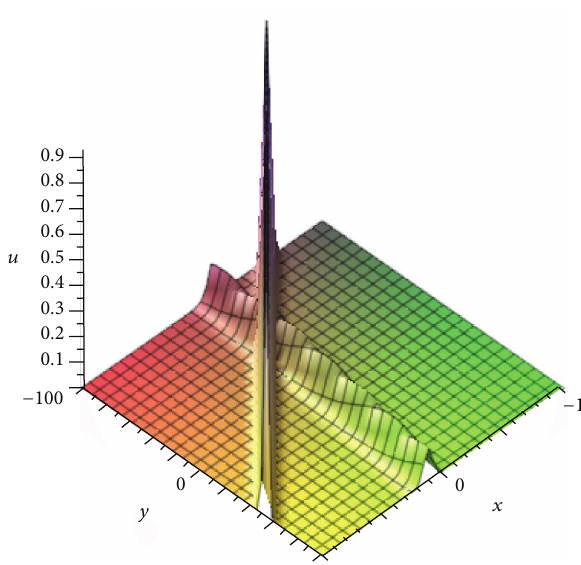
= 1 , 𝜉 0 = 1 , 𝑡 = 1 . 1 1